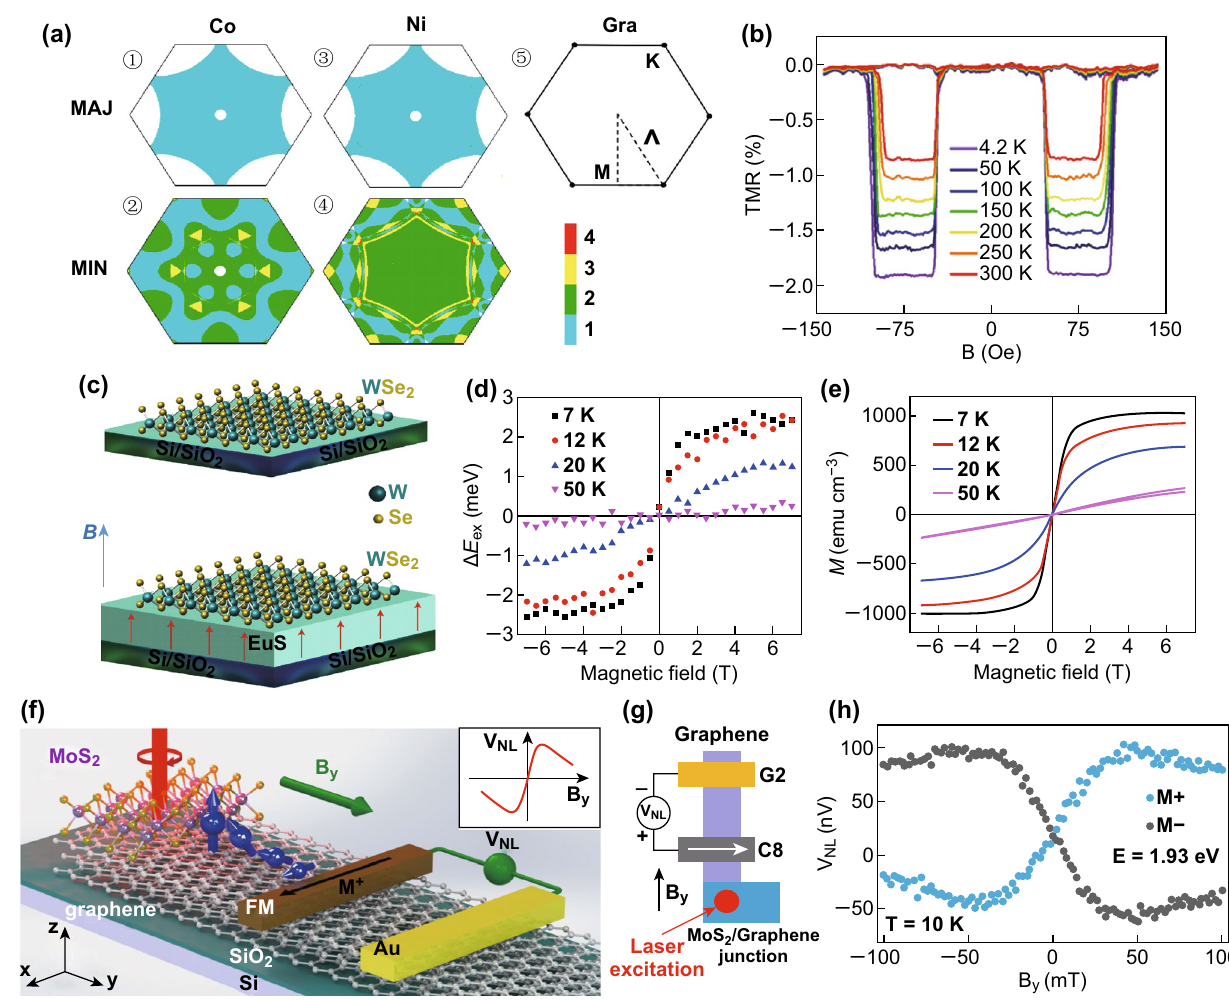
Fig. 10 Spintronic and valleytronic applications of 2D heterostructures. a The calculated majority and minority spin states of Co (①–②) and Ni (③–④) and the Fermi surface of graphene (⑤), and the color bar indicates the number of Fermi surface sheets. Reprinted with permission from Ref. [118]. b TMR of the NiFe/Gra–hBN/Co magnetic junction at a different temperature. Reprinted with permission from Ref. [119]. WSe 2 on the SiO 2 substrate and the EuS substrate ( c ), and the valley splitting ( d ) and magnetization ( e ) in the WSe 2 /EuS structure under sweeping external vertical magnetic field at different temperatures. Reprinted with permission from Ref. [125]. Schematic diagram of MoS 2 /graphene heterostructure and the Hanle measurement ( f, g ) and the Hanle signal ( h ) detected after the laser excitation on the heterostructure region at a temperature of 10 K. Reprinted with permission from Ref. [126]. (Color figure